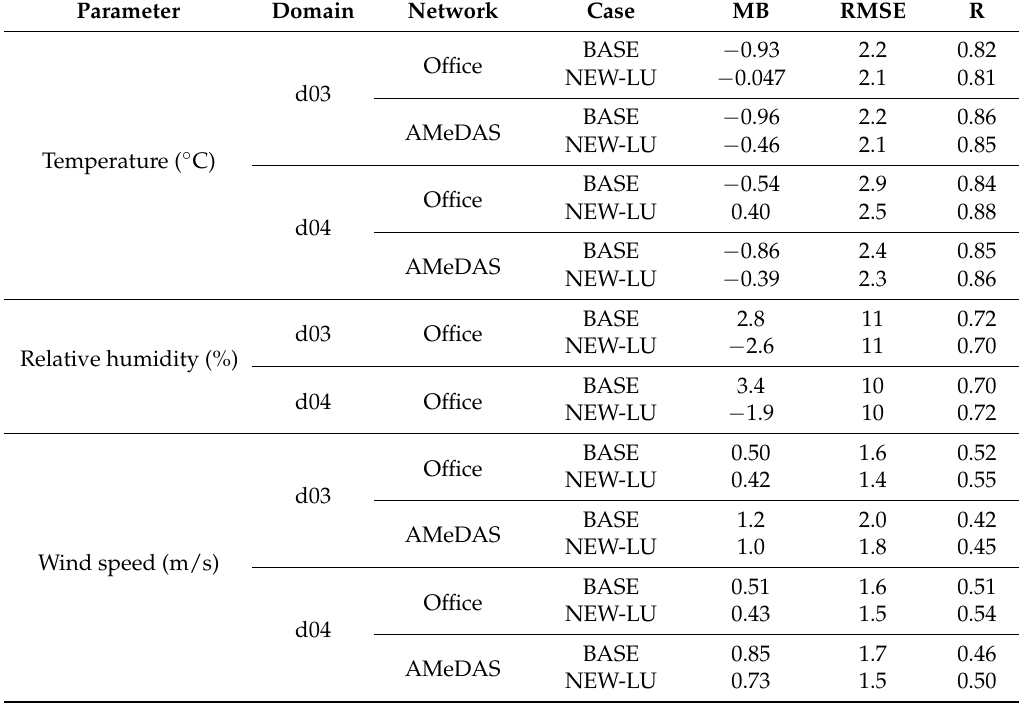
Table 3. Statistical analysis of model performance on temperature at 2 m height, relative humidity at 2 m height, and wind speed at 10 m height during the target period in d03 and d04.